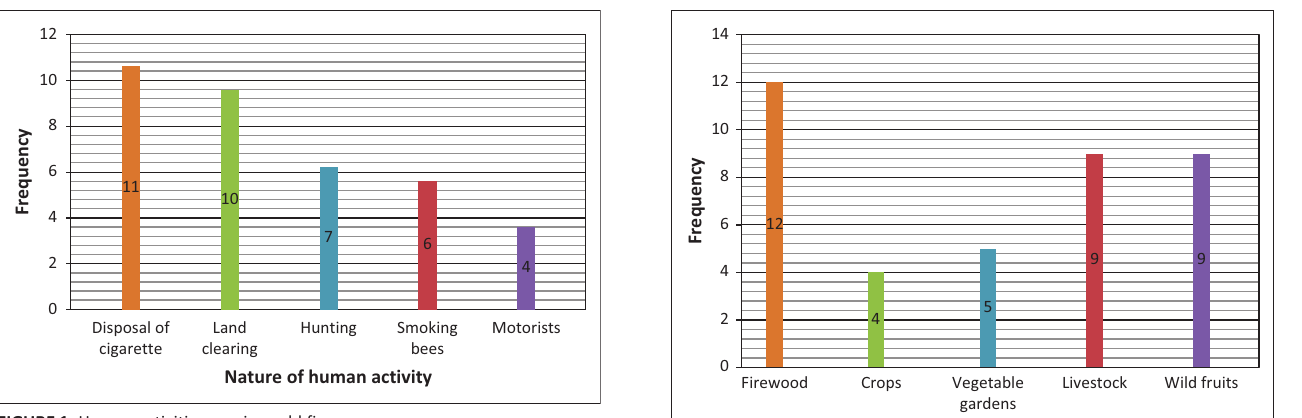
FIGURE 1: Human activities causing veld fires.